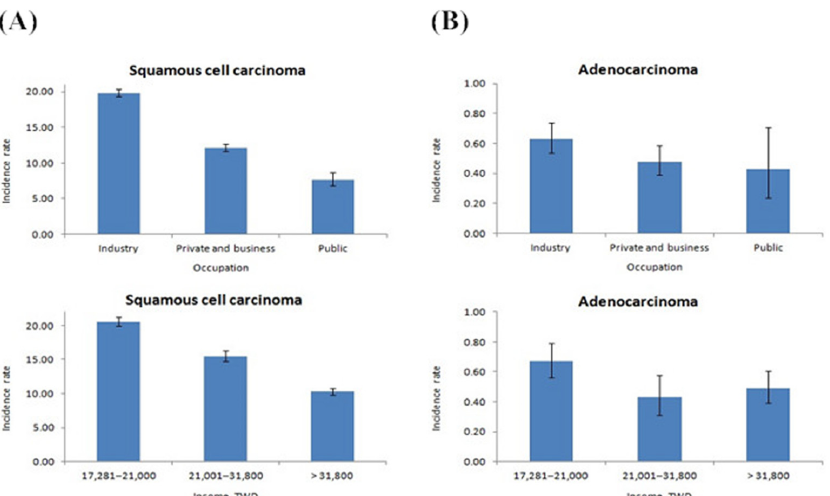
Figure 2. The crude incidence rate of occupation and income group in esophageal cancer. ( A ) The crude incidence rate of ESCC between occupation and income. ( B ) The crude incidence rate of EAC between occupation and income.